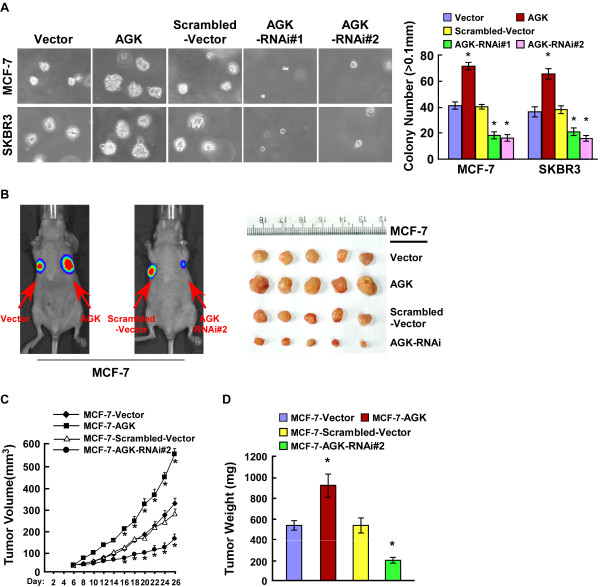
AGK promotes the tumorigenicity of breast cancer cells in vitro and in vivo. (A) Anchorage-independent growth assays of AGK-overexpressing cells and AGK-silenced cells. The number of colonies with a diameter larger than 0.1 mm was quantified after 10 days of culture. (B-D) Xenograft model in nude mice. MCF-7-AGK, MCF-7-AGK-RNAi and the respective control cells were inoculated into the fat-pad of nude mice (n = 5/group). (B): Representative images of tumor-bearing mice (left panel) and images of the tumors from all mice in each group (right panel). (C) Tumor volumes were measured on the indicated days. (D) Mean tumor weights. Each bar represents the mean ± SD of three independent experiments. *P < 0.05.